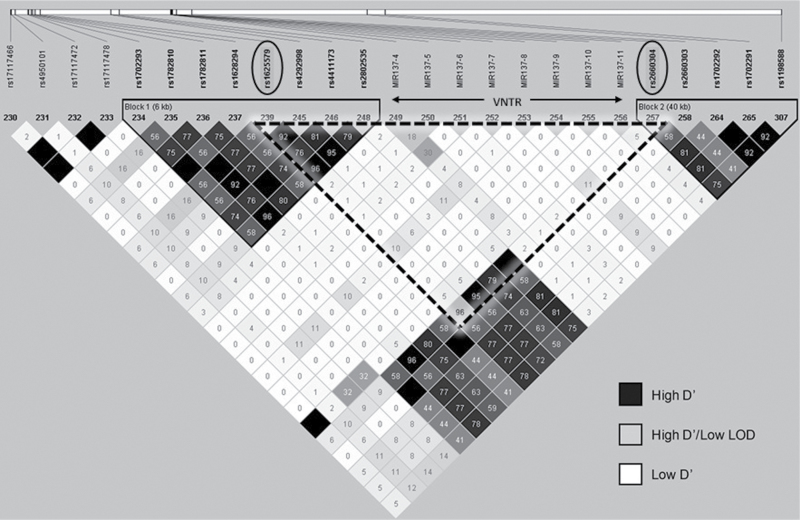
Linkage disequilibrium (LD) analysis of MIR137 gene locus. Haplotype block structure of the MIR137 gene based on squared correlation coefficient (r
2) values calculated from 89 individuals from the CEPH collection of the International HapMap Project using the Linkage Format feature in Haploview 4.2 (Hardy-Weinberg P value cut-off, .001; minimum genotype cut-off, 0.75; maximum number of Mendel errors, 1; minimum minor allele frequency, 0.01). Single nucleotide polymorphisms (SNPs) spanning chromosome 1: 98,075,522-98,711,836 were downloaded from the HapMap Genome Browser, release #28 (http://hapmap.ncbi.nlm.nih.gov/index.html.en). Haplotype blocks, represented by a solid black triangular border, were determined using 95% confidence intervals proposed by Gabriel et al13 which defined 2 haplotype blocks separated by the MIR137 variable number tandem repeat (VNTR) which is located within a recombination hot spot represented by white squares. Pair-wise tagging SNP analysis (r
2 > 0.8) revealed that the genome-wide association studies (GWAS) SNP rs1625579 and the MIR137 VNTR were not in LD. However, high LD (r
2 = 0.96) was observed between rs1625579 and the internal MIR137 promoter SNP rs2660304, demarcated by a dashed triangular border.